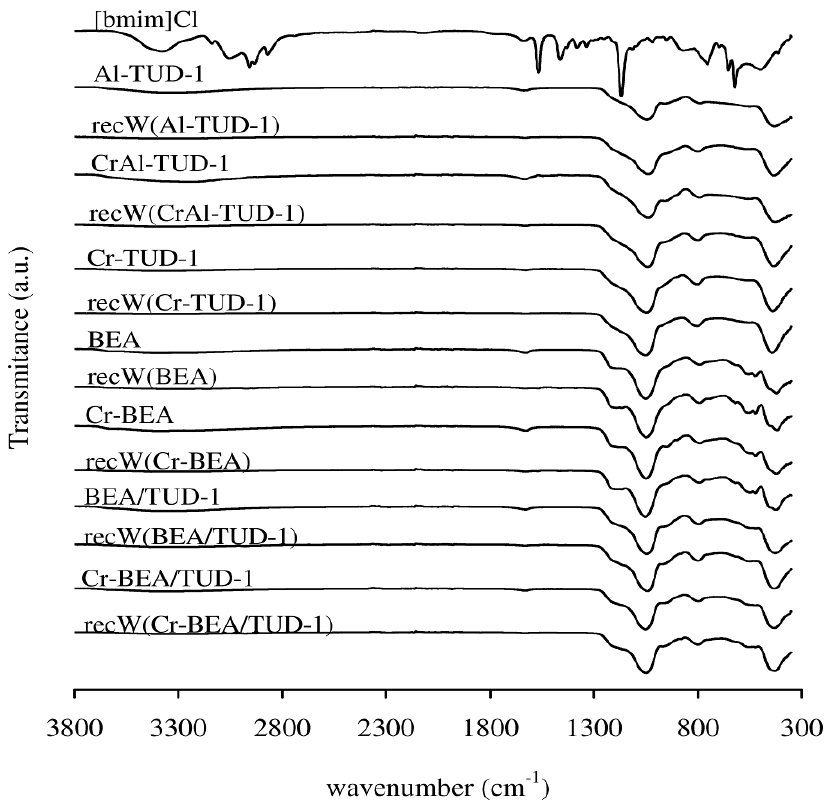
Figure 5. FT-IR ATR spectra of prepared materials and the respective recW